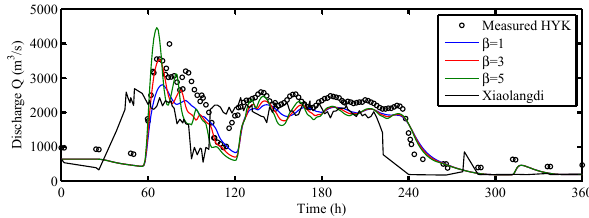
Fig. 3. Computed and measured discharge at Huayuankou, with ref- erence to the discharge at